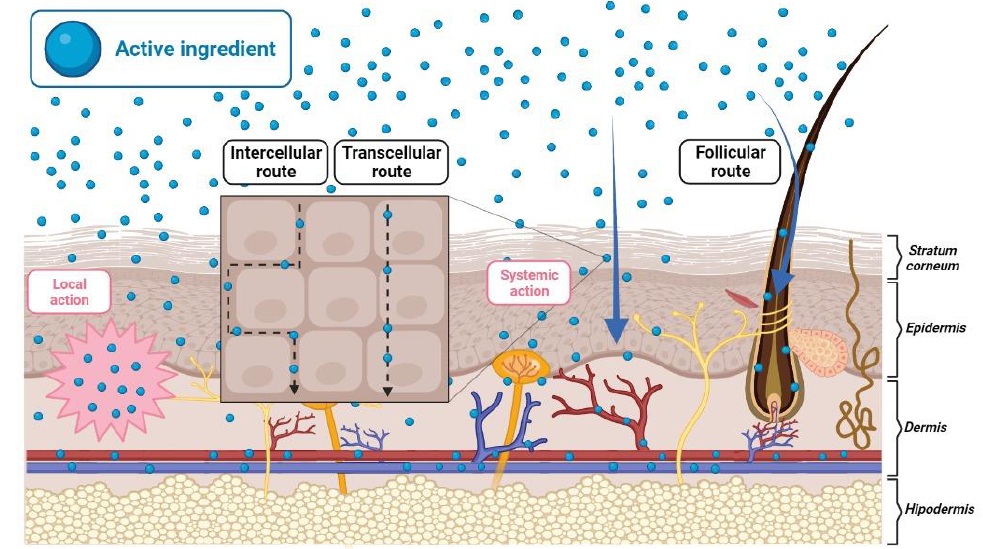
Figure 1. Skin layers and drug delivery routes for systemic and local